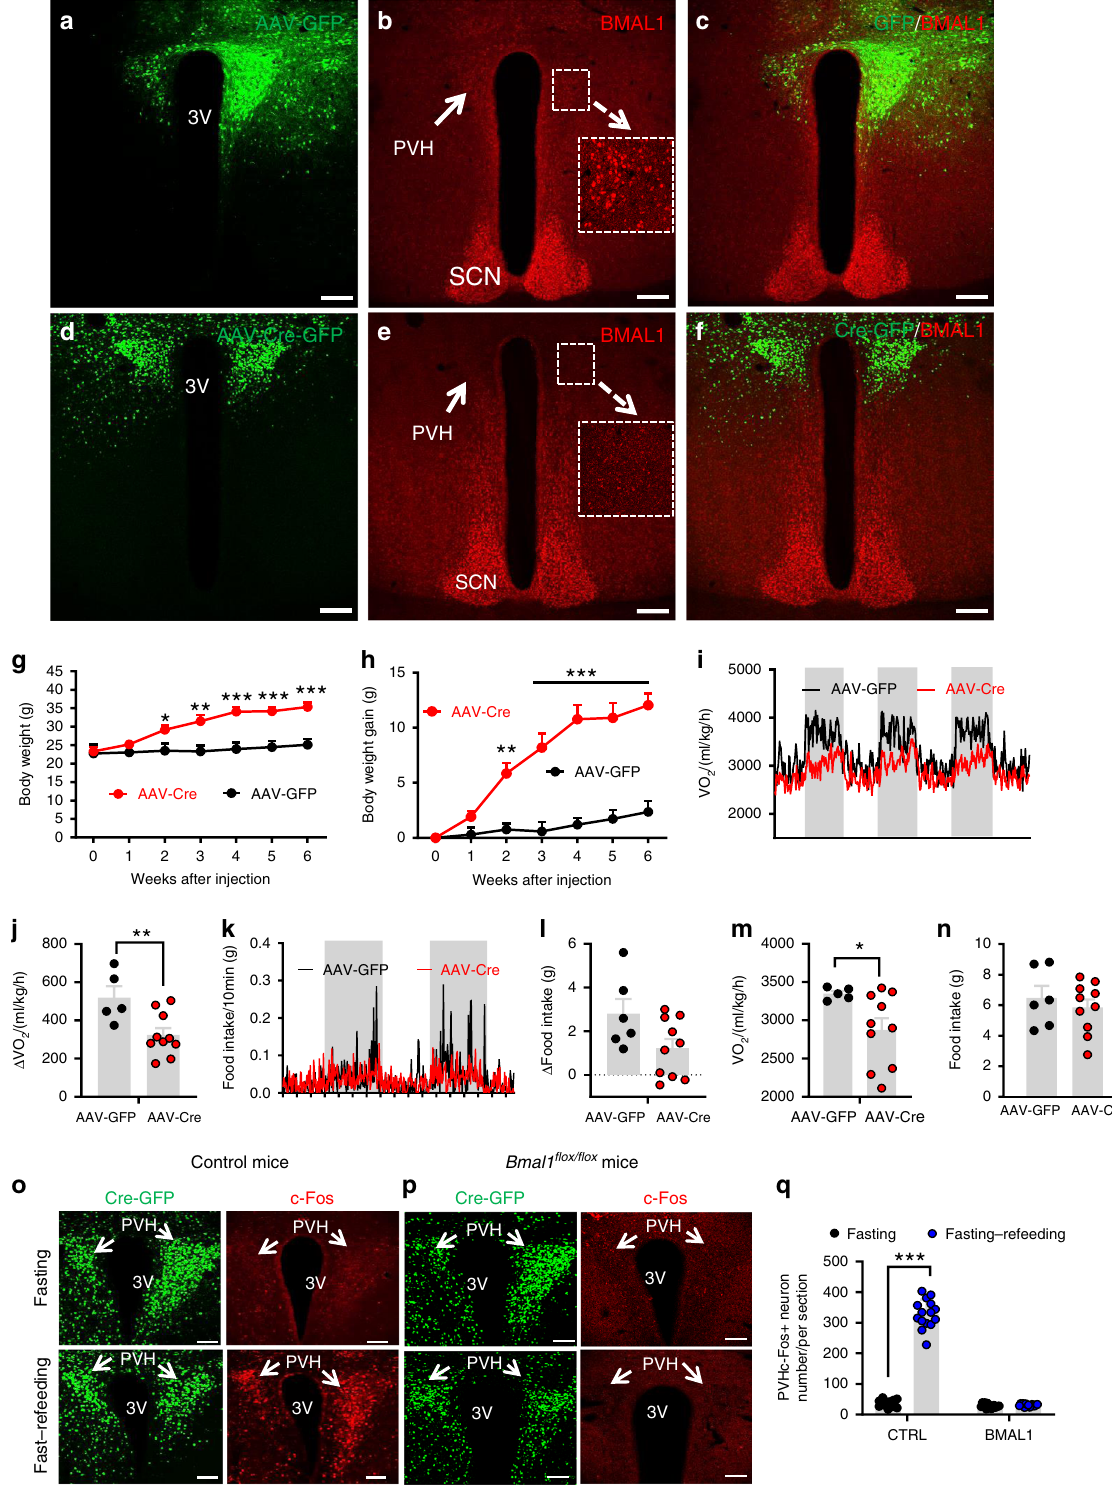
aforementioned data suggest that BMAL1 in the PVH is required for neuron responsiveness, diurnal rhythms in metabolism, and normal body weight regulation. To con fi rm whether defective PVH neuron responsiveness has a causal role in loss of diurnal reason that one effective way is to “ lock ” the activity of PVH